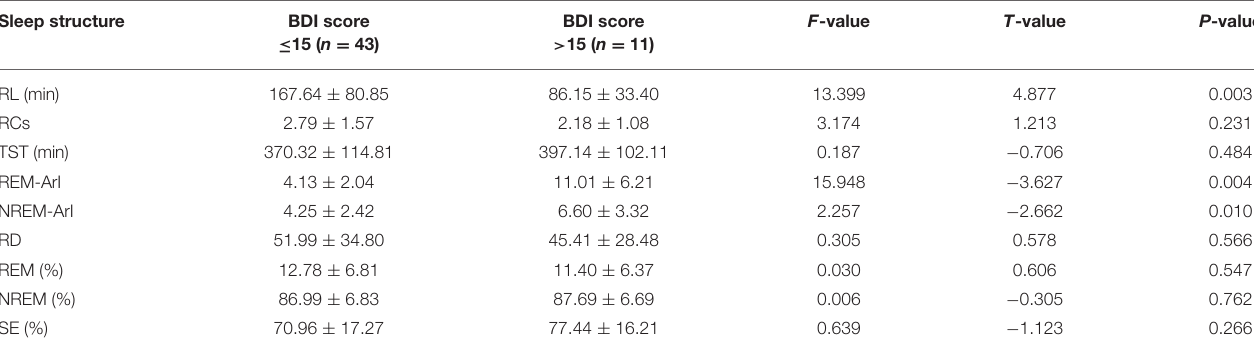
TABLE 2 | Independent sample t -test of sleep structure of the two groups of patients (BDI score classification after 3 months of follow-up). Sleep